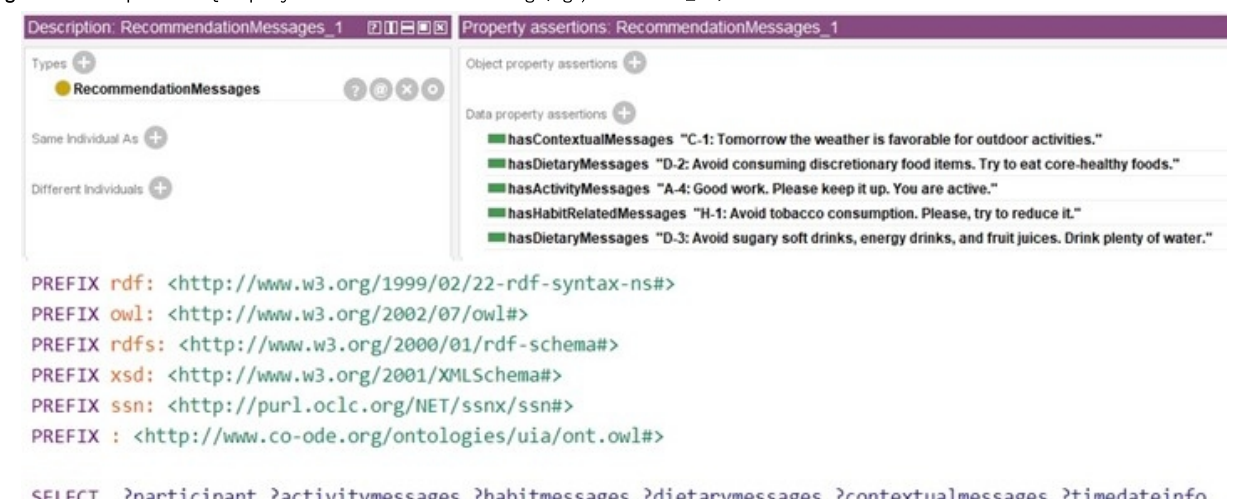
Figure 19. Sample SPARQL query for recommendation finding (e.g.,